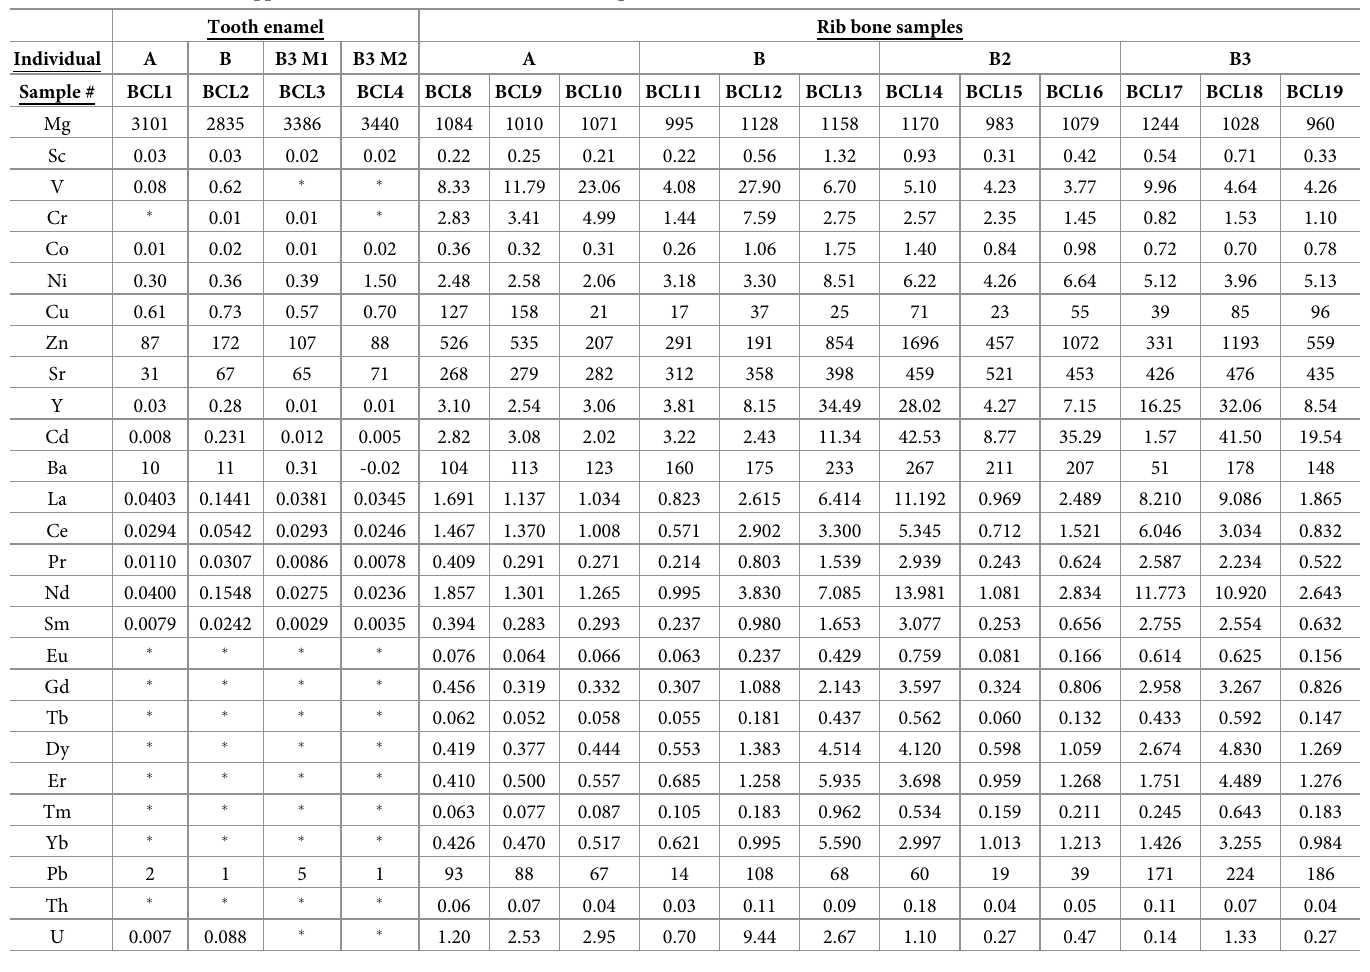
Table 3. Trace element data (ppm) for YNH4 tooth enamel and bone samples. Tooth enamel Rib bone